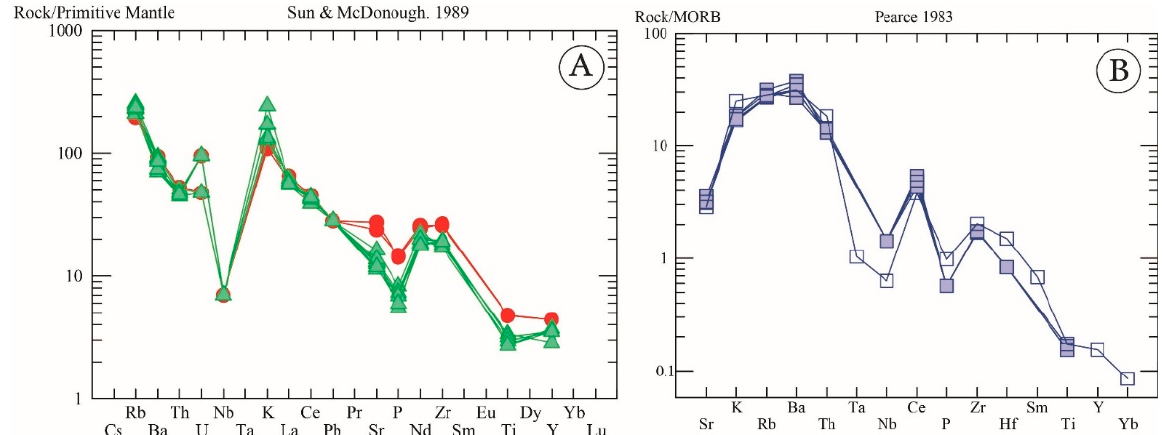
Figure 11. Trace elements spidergram of TSESDAI andesites and dacites normalized to N-type MORB ( A ), and of a TSESDAI rhyolitic dome normalized to ORG ( B ). See symbol legend in Figure 8.